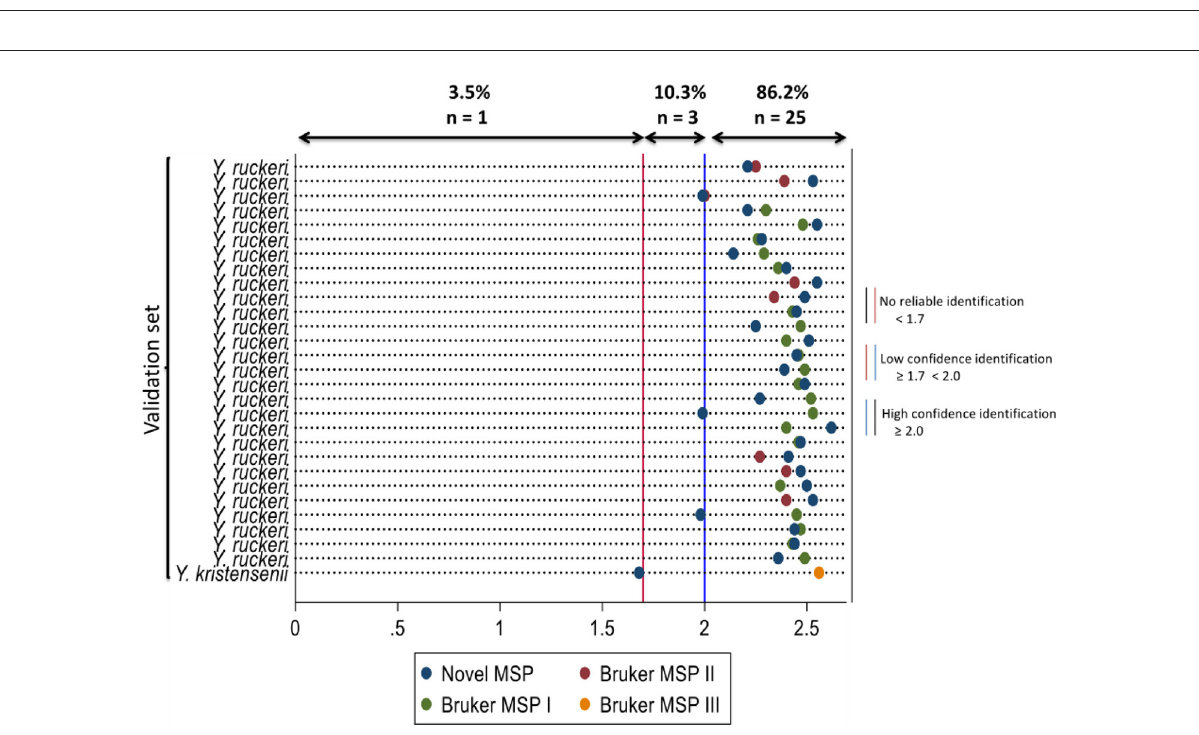
FIGURE2 Dot diagram showing the organism that best matches the isolates in the validation set using the novel main spectral profile and the Bruker main spectral profiles with their respective log scores for MALDI-TOF MS identification. Novel MSP, Yersinia ruckeri 15945-2008 AVC 2021; Bruker MSP